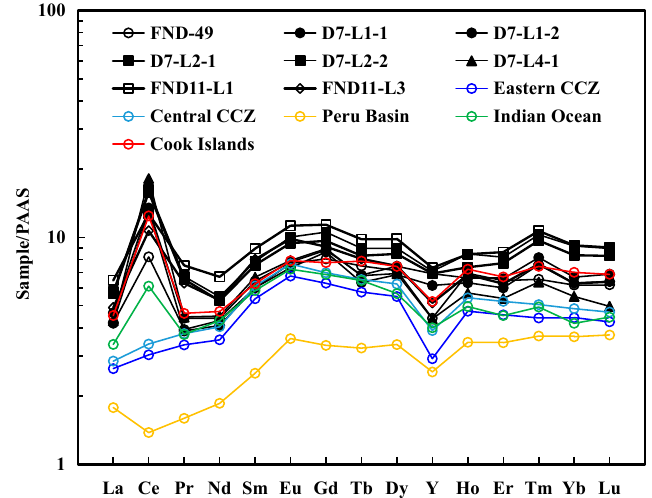
Figure 4. Post-Archaean Australian shale (PAAS)-normalized [20] rare earth element and yttrium (REY) distribution patterns of each layer using the ICP-MS analysis data of each layer. The negative Ce anomaly occurs in every individual layer. Other data are taken from Hein and Koschinsky (2013) and Hein et al. (2015) [1,16].